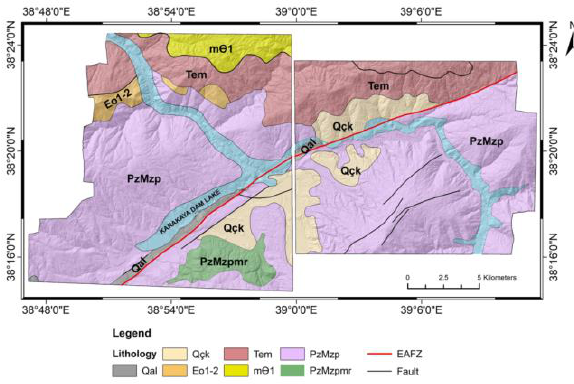
Figure 3. Lithological units in the study area provided